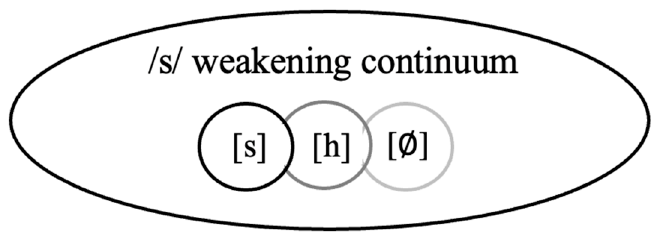
Figure 1. Coda /s/ weakening continuum: sibilance, aspiration, and elision.